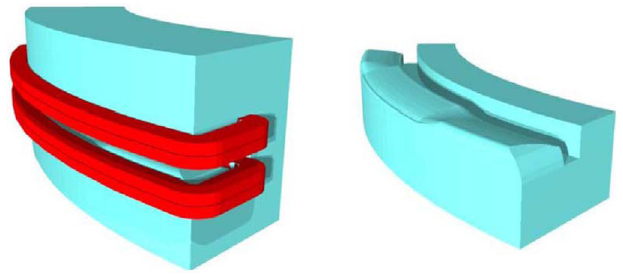
FIG. 13. Schematic view of the main magnet. In the right-hand figure, the upper half of the magnet core is omitted to show the pole